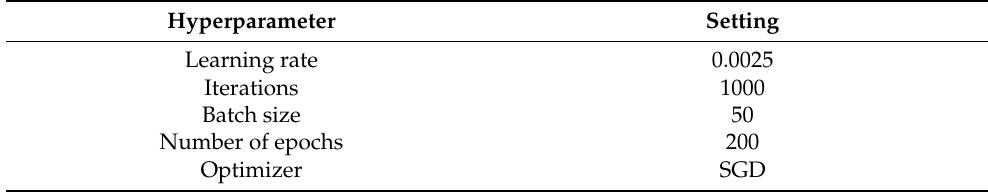
Table 2. The setting of hyperparameters.